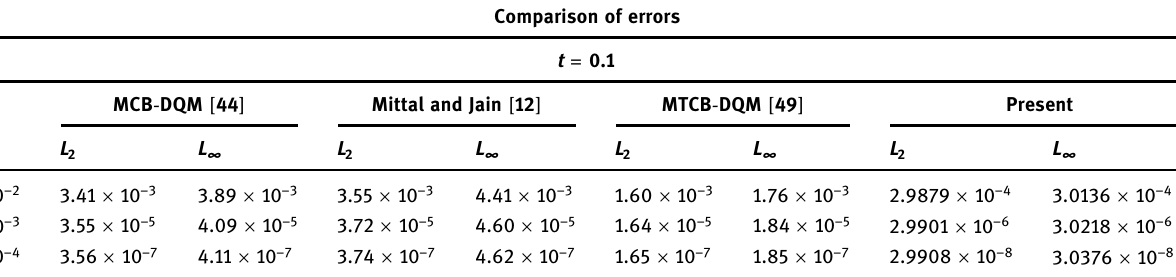
Table 3: Comparison of errors at = t 0.1